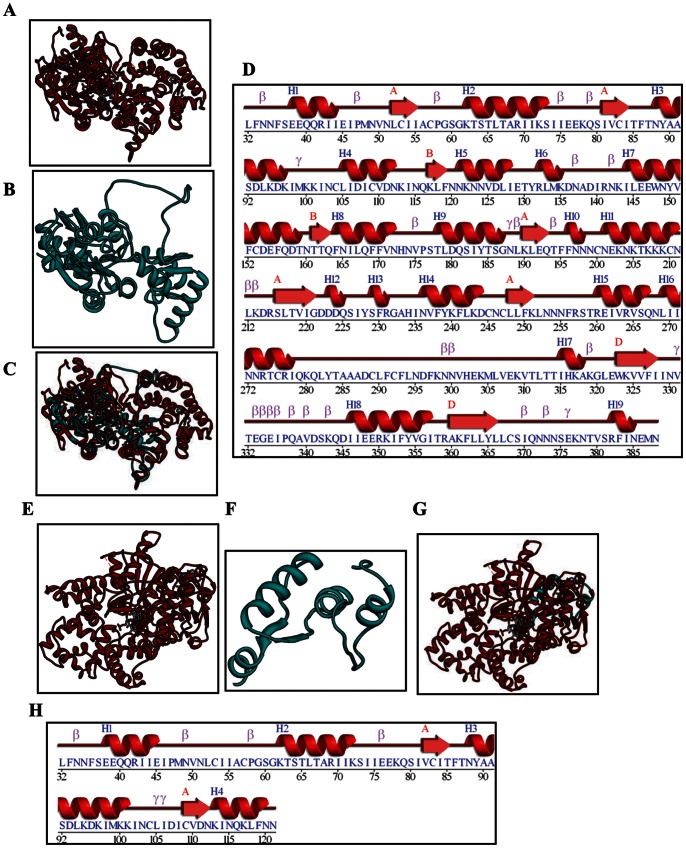
Structure modelling of synthetic UvrD.A–C. sUD sequence was submitted to Swissmodel server and the structure was obtained. A. Template B. sUD C. superimposed image. D. Secondary structure of sUD. E–G. sUDN1N2 sequence was submitted to Swissmodel server and the structure was obtained. E. Template; F. sUDN1N2; G. superimposed image. D. Secondary structure of sUDN1N2.